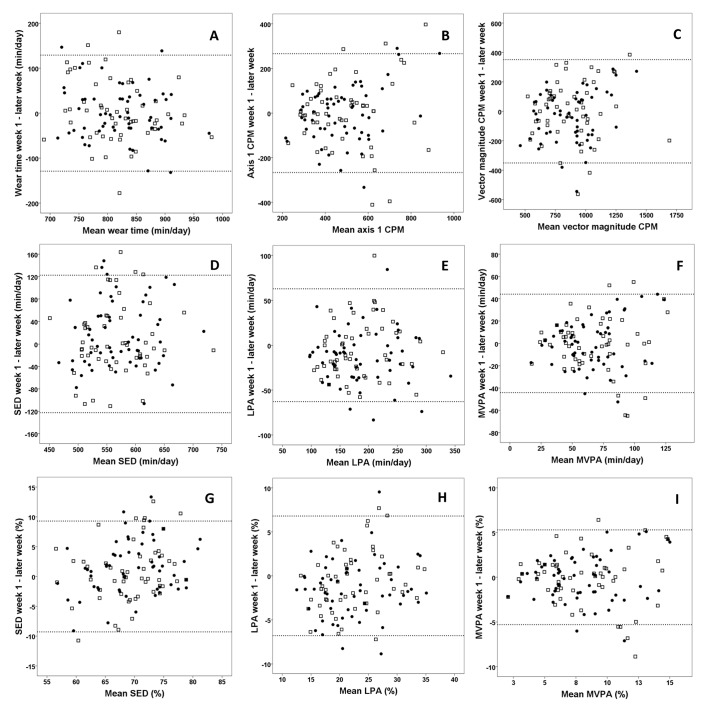
Bland Altman plots of measurement variability for different outcome variables.Bland Altman plots (the difference between two weeks of measurement on the y-axis versus the mean of the two weeks on the x-axis) for wear time (a); average counts per minute (CPM) from the vertical axis (b) and the vector magnitude (VM CPM) (c); absolute time spent sedentary (SED) (d), light physical activity (LPA) (e) and moderate-to-vigorous physical activity (MVPA) (f); percentage time in SED (g), LPA (h) and MVPA (i). Results are based on a ≥10 hours & ≥4 days wear time criteria. Filled dots are week 1–week 2 (n = 59); open squares are week 1–week 3 (n = 53)95% limits of agreement are indicated as dotted lines.